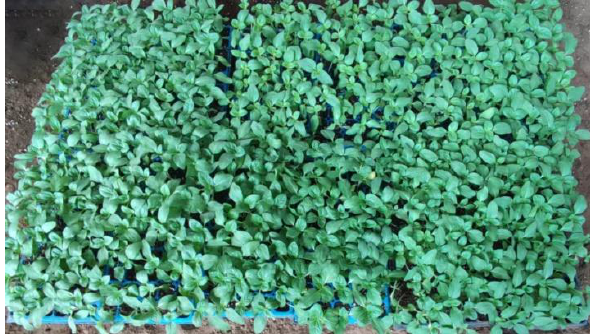
Figure 1. Oil sunflower plug seedlings at the planting stage.